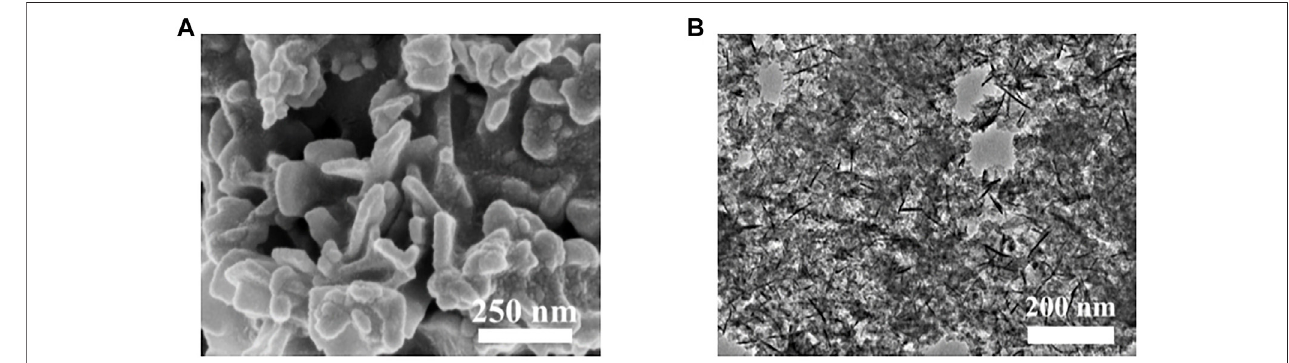
100 mA cm − 2 at 1.526 V ( η = 296 mV), respectively. The